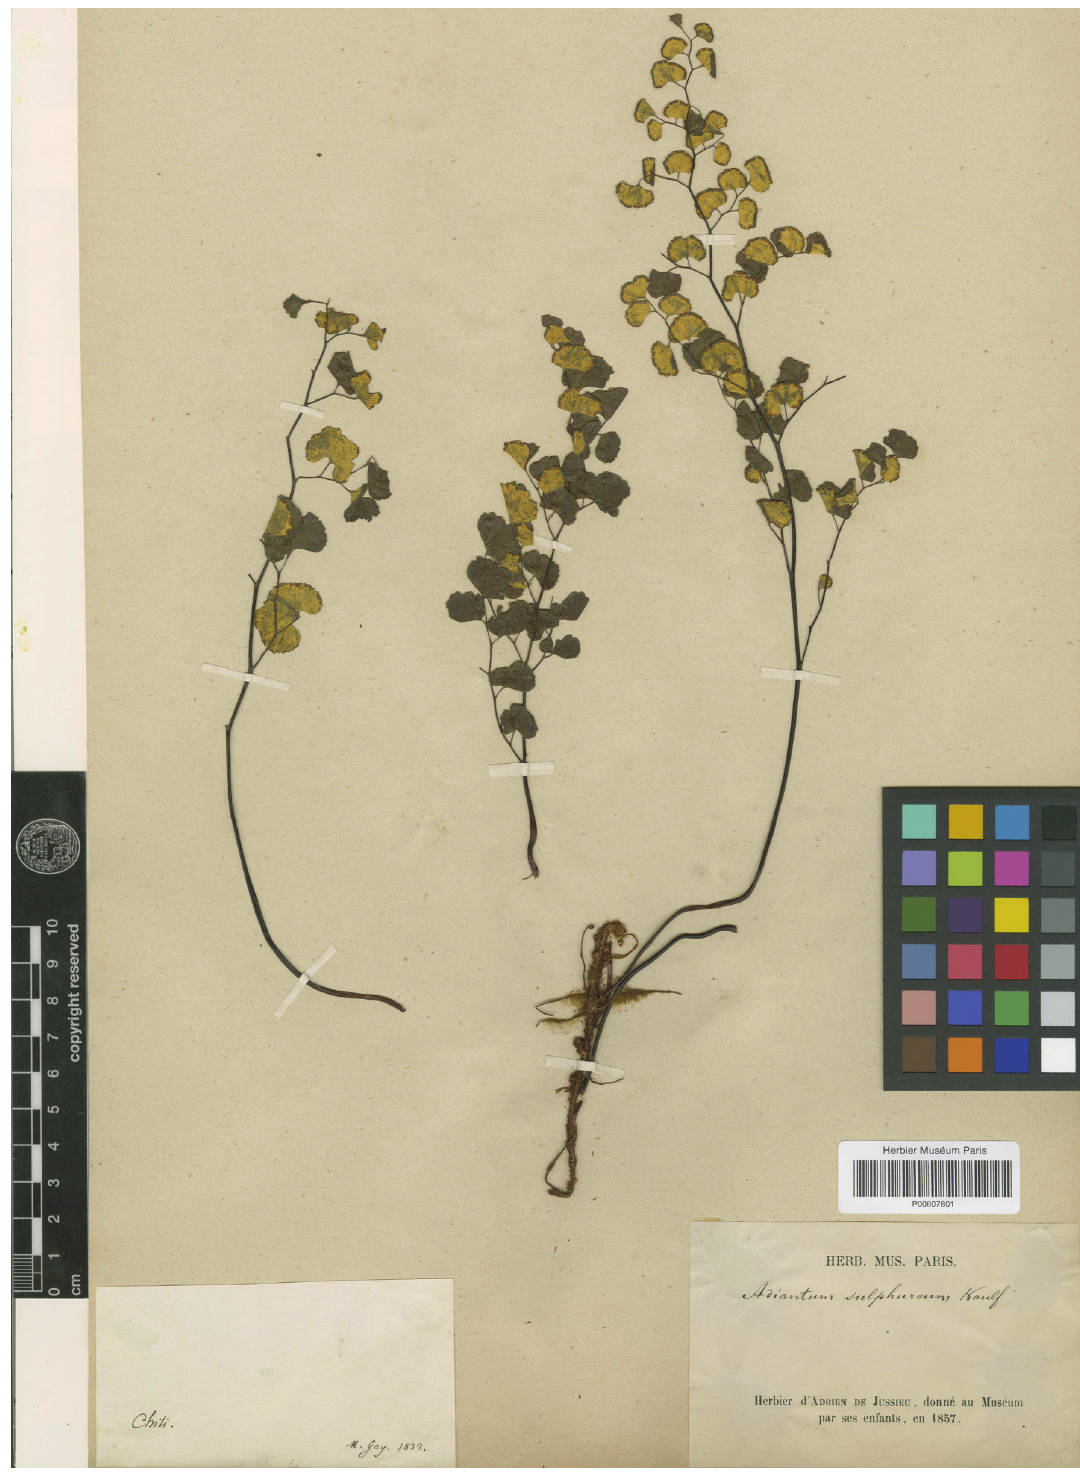
Figure 3: Adiantum poiretii , collected by Gay in Colchagua, Herbier d’Adrien de Jussieu, Muséum d’Histoire naturelle .